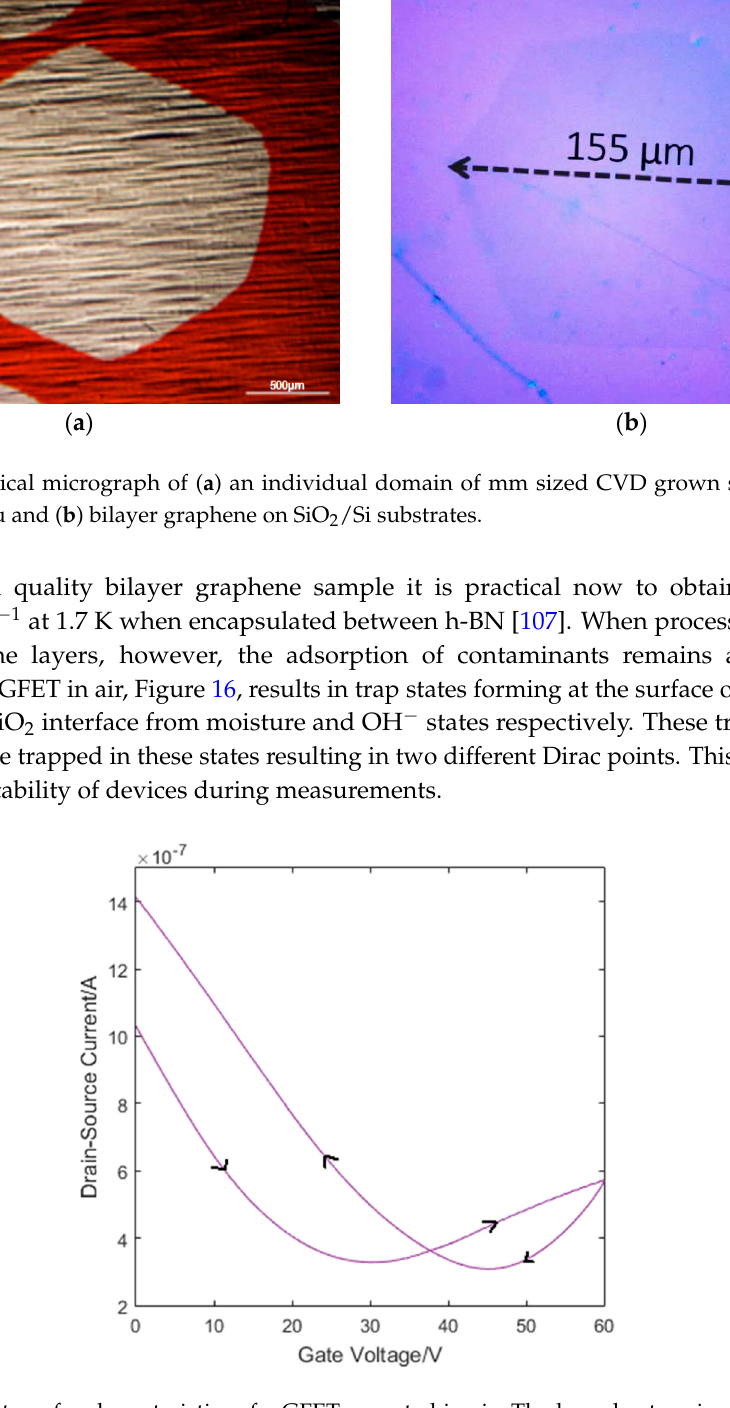
Figure 16. The transfer characteristics of a GFET operated in air. The large hysteresis at two Dirac points is due to trapping of charge carriers. The arrows denote the sweep direction.